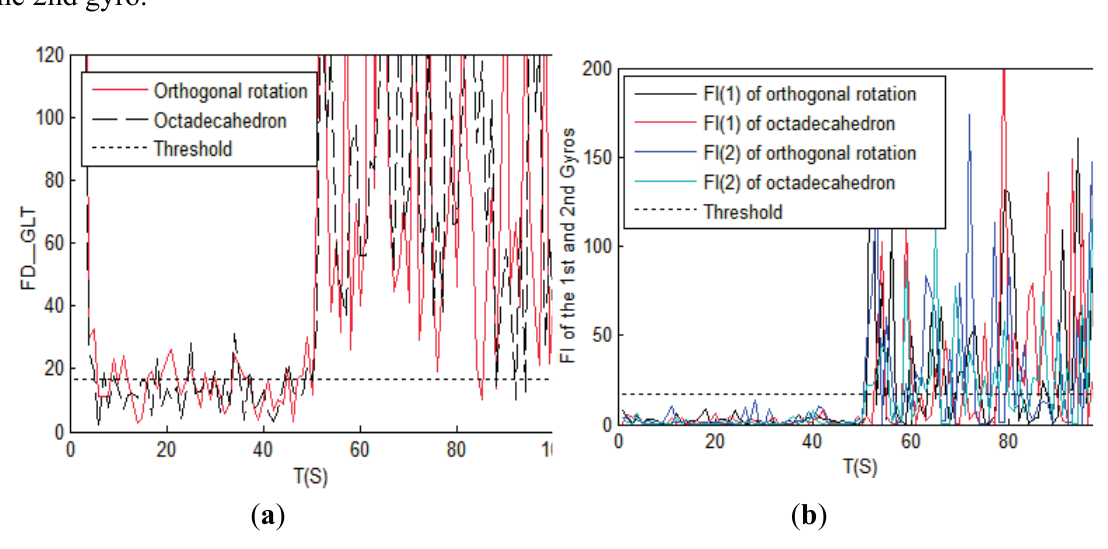
Figure 10. Double-fault detection and isolation of the octadecahedron and the orthogonal rotation configurations: ( a ) Fault judgment curves; ( b ) Fault detection curves of the 1st and the 2nd